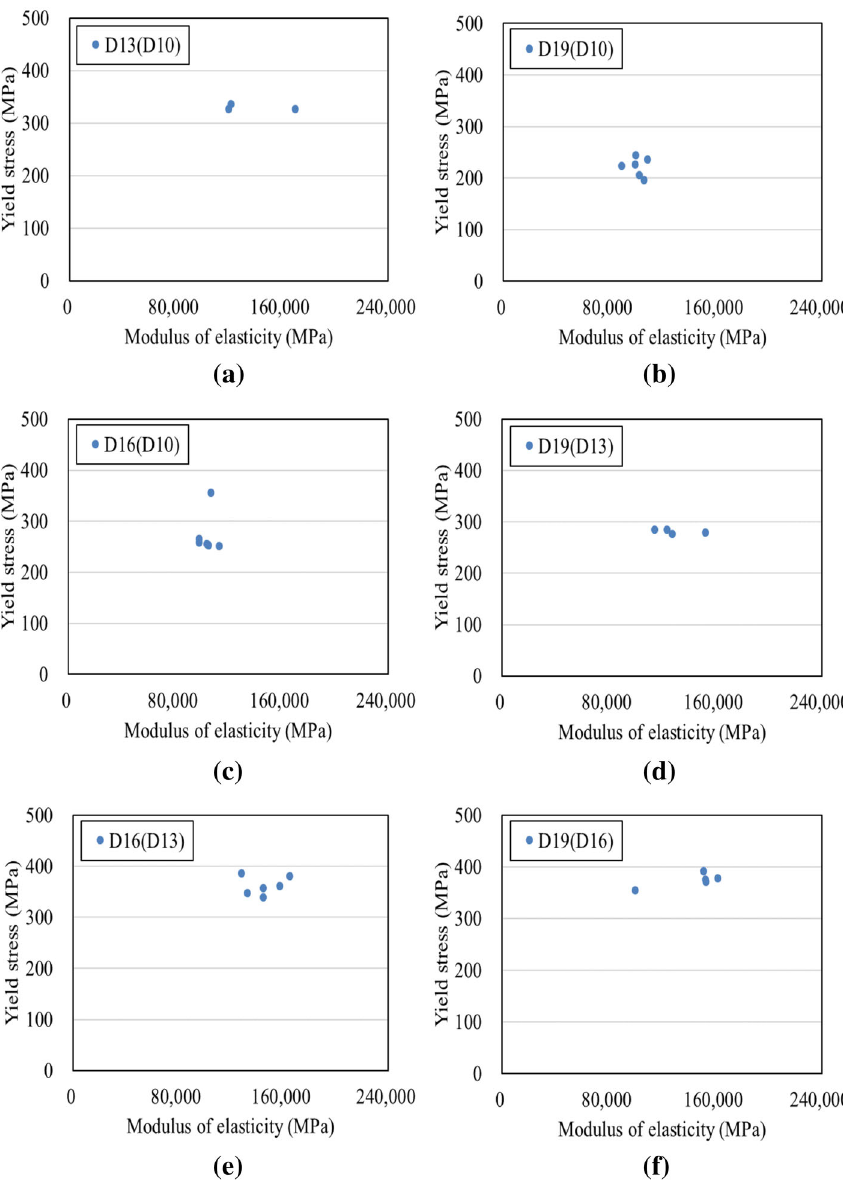
Fig. 9 Yield stress and modulus of elasticity relationship. a D13(D10) specimens, b D16(D10) specimens, c D16(D13) specimens, d D19(D10) specimens, e D19(D13) specimens, f D19(D16)